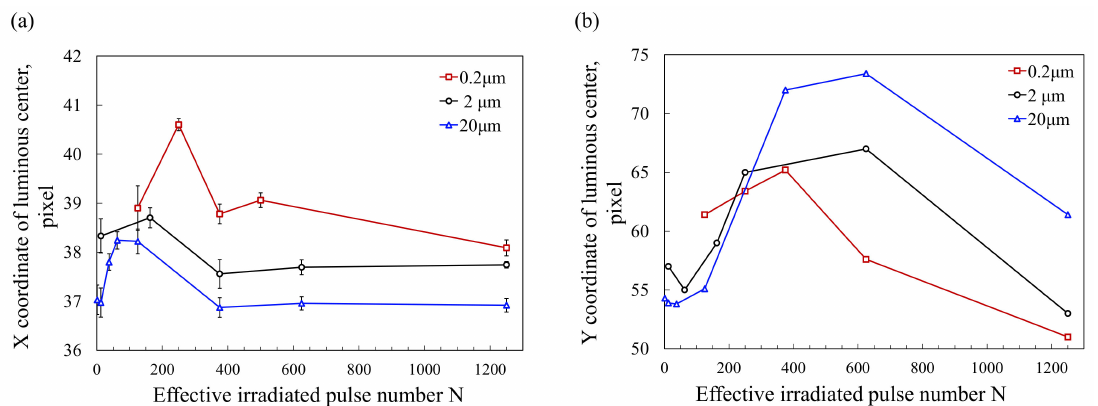
Figure 10. The coordinates of the luminous center change with the effective irradiated pulse number: ( a ) X coordinate, ( b ) Y